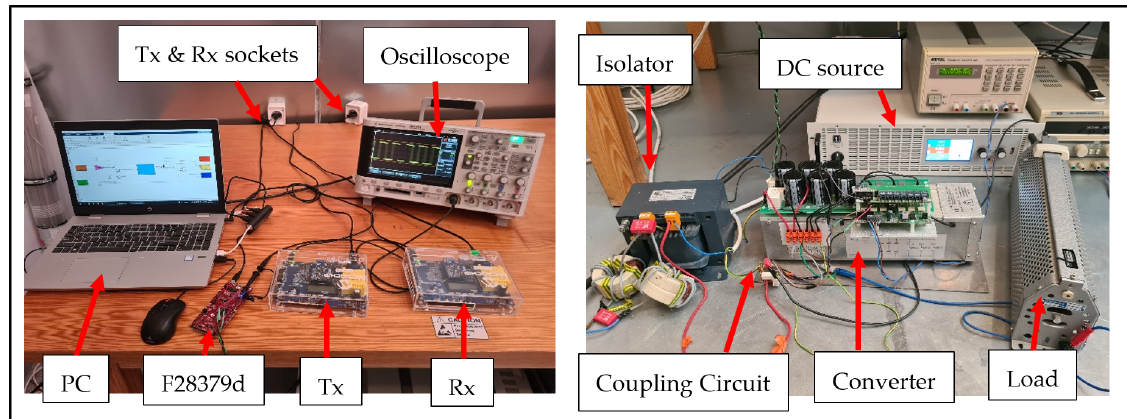
Figure 5. Experimental test